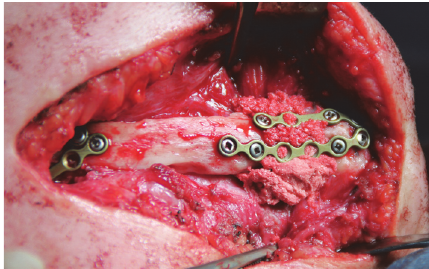
Figure 2: Intraoperative view: nonunions are removed; mandible fragments and rib autograft are fixed with miniplates; bone defects filled with gene-activated bone